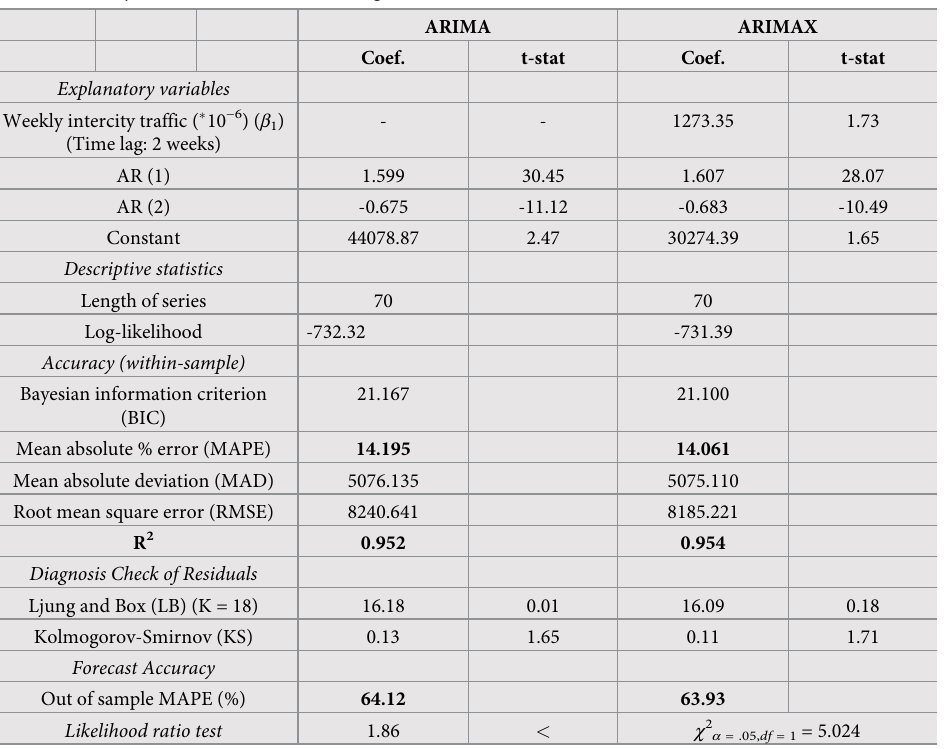
Reviewing Table 4, all the independent variables are statistically significant at a 10% signifi- cance level. Moreover, the ARIMA model indicates an R-squared value of 0.952, which denotes that over 95% of the variations in the current weekly new COVID cases are explained only by considering the serial correlations in the underlying time series. Besides, the multivariate ARI- MAX model outperforms the univariate model slightly, regarding the increase in the coeffi- cient of determination and the log-likelihood value. Nonetheless, the likelihood ratio rejects the hypothesis of statistical significance of the fit superiority of the ARIMAX model at a 5% significance level. Meanwhile, the significant coefficient value of the weekly intercity traffic demonstrates that each one million more intercity traffic is associated with an approximate 1273 more weekly new confirmed COVID cases after two weeks, given that other influential factors remain constant. Moreover, the MAPE criterion demonstrates that the developed instruments properly reconstruct observations with only about 14% mean absolute error. On the other hand, the out-of-range prediction power of the Box-Jenkins methodology was not appropriate based on the MAPE criterion, although the developed model performs well in the short-term predictions. This is not surprising as the influential factors on the COVID trends are not limited to the intercity traffic pattern. Considering factors such as the percentage of compliance with health protocols will strengthen the model’s ability to make medium-term predictions based on causal relationships if such data is available. Finally, the model diagnosis checking is conducted by testing the white noise characteristics of the residuals in terms of non-autocorrelation, zero mean, and stationarity in the variance. The ACF/PACF plots of the residuals do not represent any significant coefficients at a 5% sig- nificant level except the first lag (see Fig 7). Besides, the LB and KS test results also confirm the white noise characteristics of the residuals for both models (see Table 4).